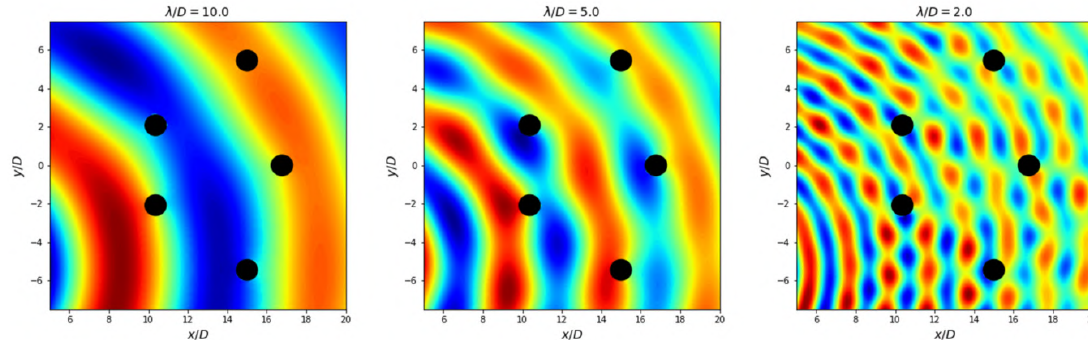
Figure 3. Wave patterns from forced oscillations of body W 1 including scattering from the other bodies.